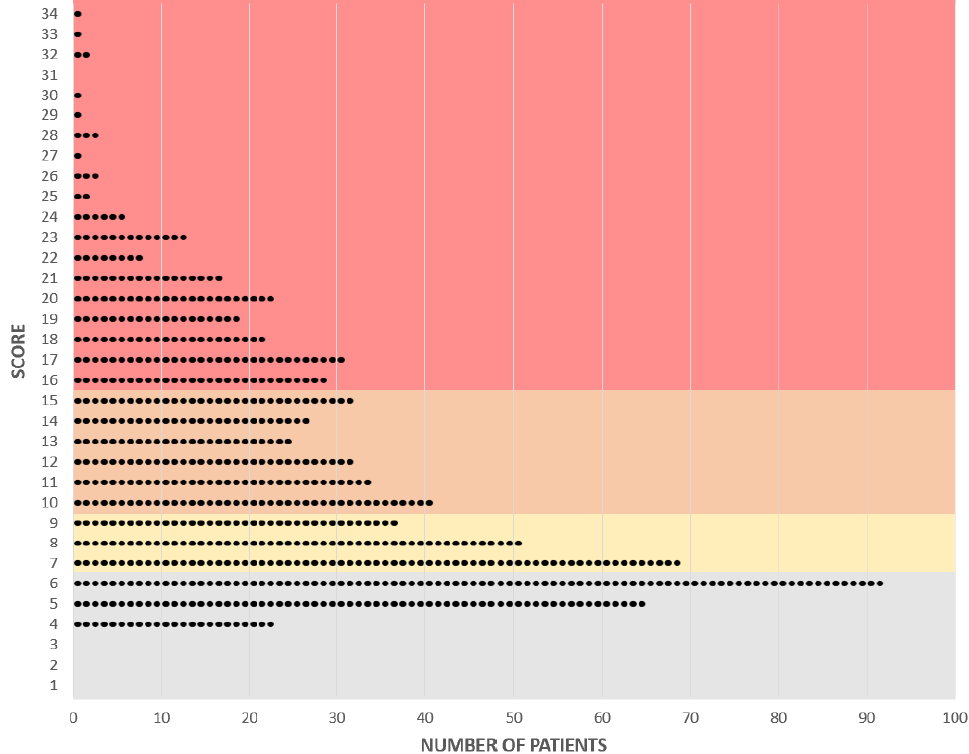
Figure 4. Graphical representation of individual scores and their allocation to the categories of complexity. Each point represents a patient. Category 1: gray, Category 2: yellow, Category 3: orange, Category 4: red.